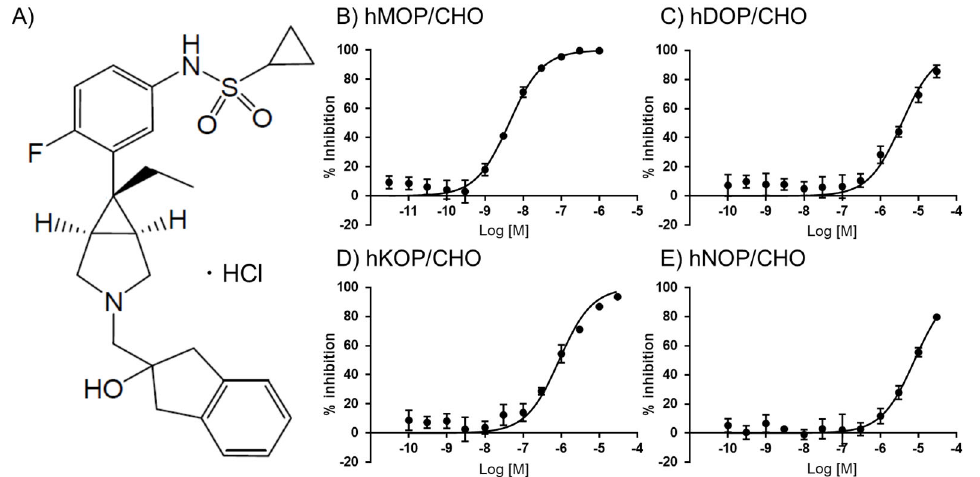
Figure 1. ( A ) Structure of UD-030. ( B – E ) Binding properties of UD-030 for displacement of the specific binding of 1 nM [ 3 H]DAMGO, 0.7 nM [ 3 H]DADLE, 1 nM [ 3 H]U-69593, and 0.5 nM [ 3 H]nociceptin to membranes of hMOR/CHO ( B ), hDOR/CHO ( C ), hKOR/CHO ( D ), and hNOP/CHO ( E ) cells, respectively. Assays were performed on two separate occasions, each in triplicate. The data are expressed as the mean ±